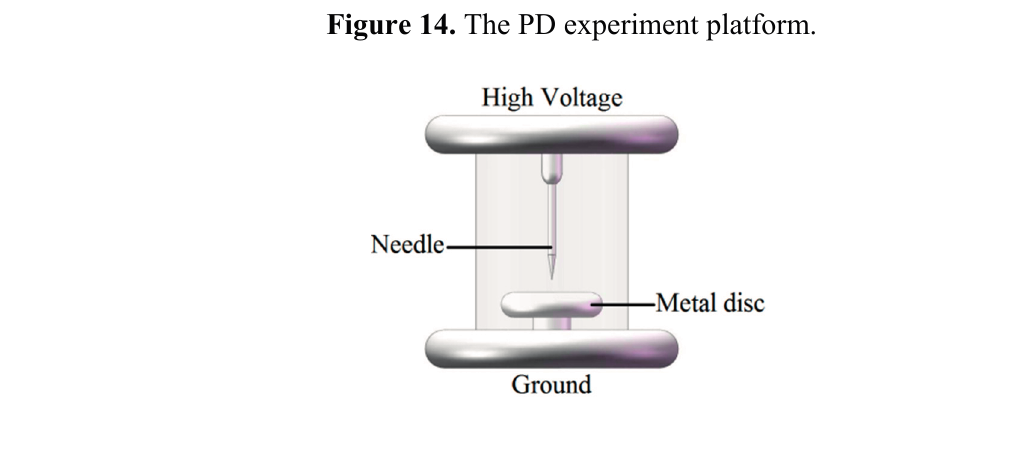
Figure 15. The artificial defect